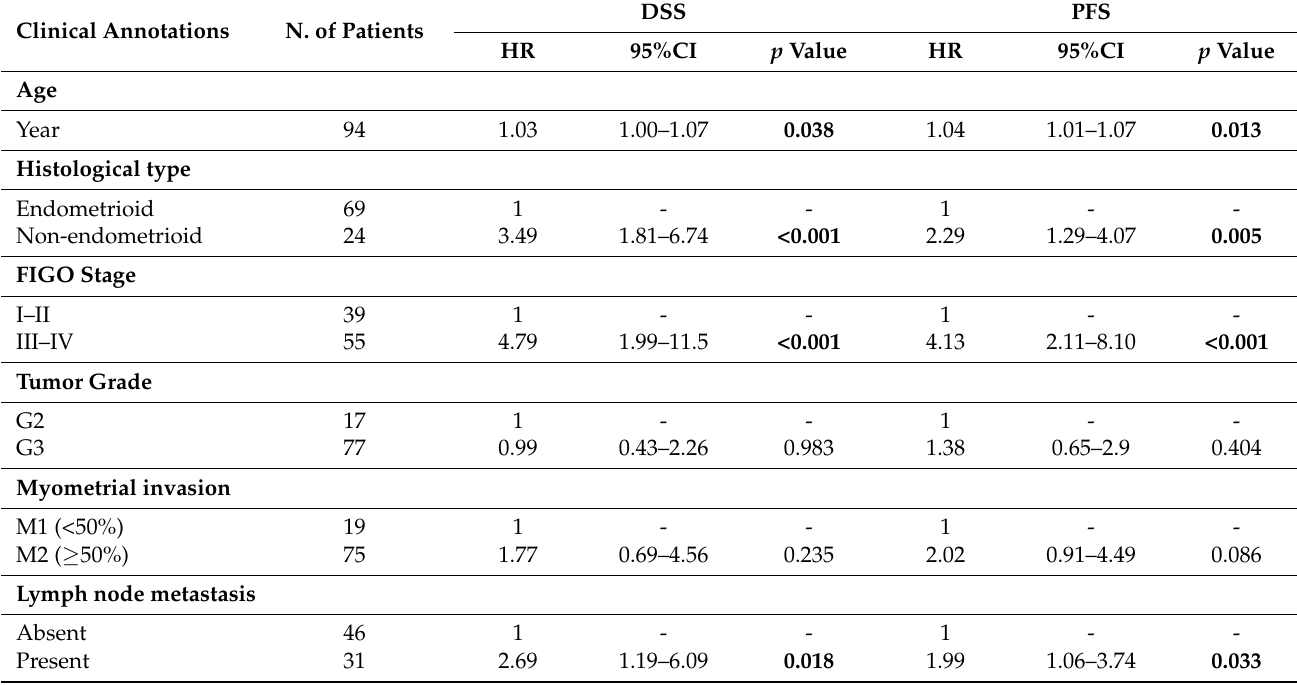
Table A2. Univariable survival analysis for disease-specific survival (DSS) and progression-free survival (PFS) accounting for clinicopathological variables in the Brescia